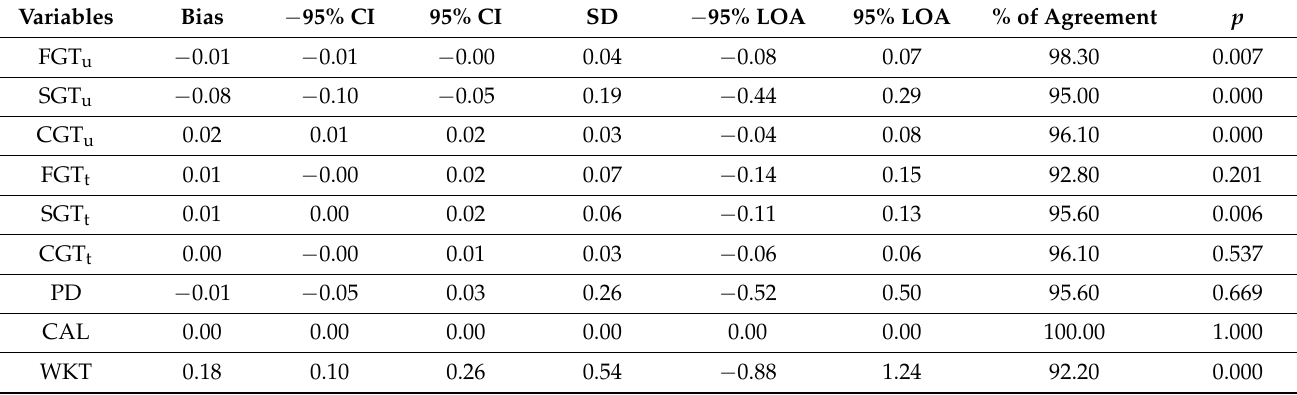
Table 4. Inter-examiner agreement of measurement between two examiners.